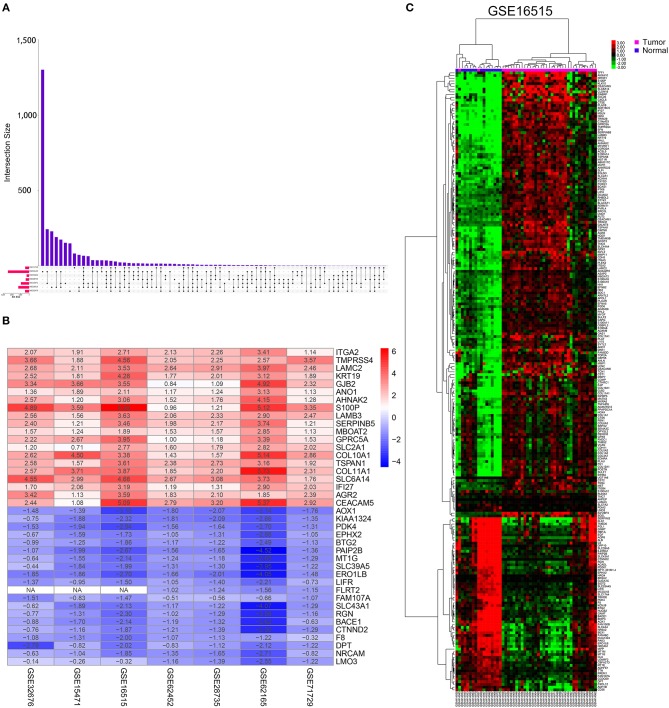
Identification of DEGs in pancreatic cancer between tumor and normal tissues. (A) UpSet Venn diagrams of the DEGs identified in seven GEO datasets. (B) The heat map of top 20 up-regulated and down-regulated DEGs identified by integrated analysis of the GEO datasets. The up-regulated DEGs are showed in red while the down-regulated DEGs are showed in blue. The value in each column represents the value of Log2FC. (C) Representative heatmap of the DEGs after integrated analysis in GSE16515 shows that the 234 DEGs can effectively distinguish tumors from non-tumor tissues.